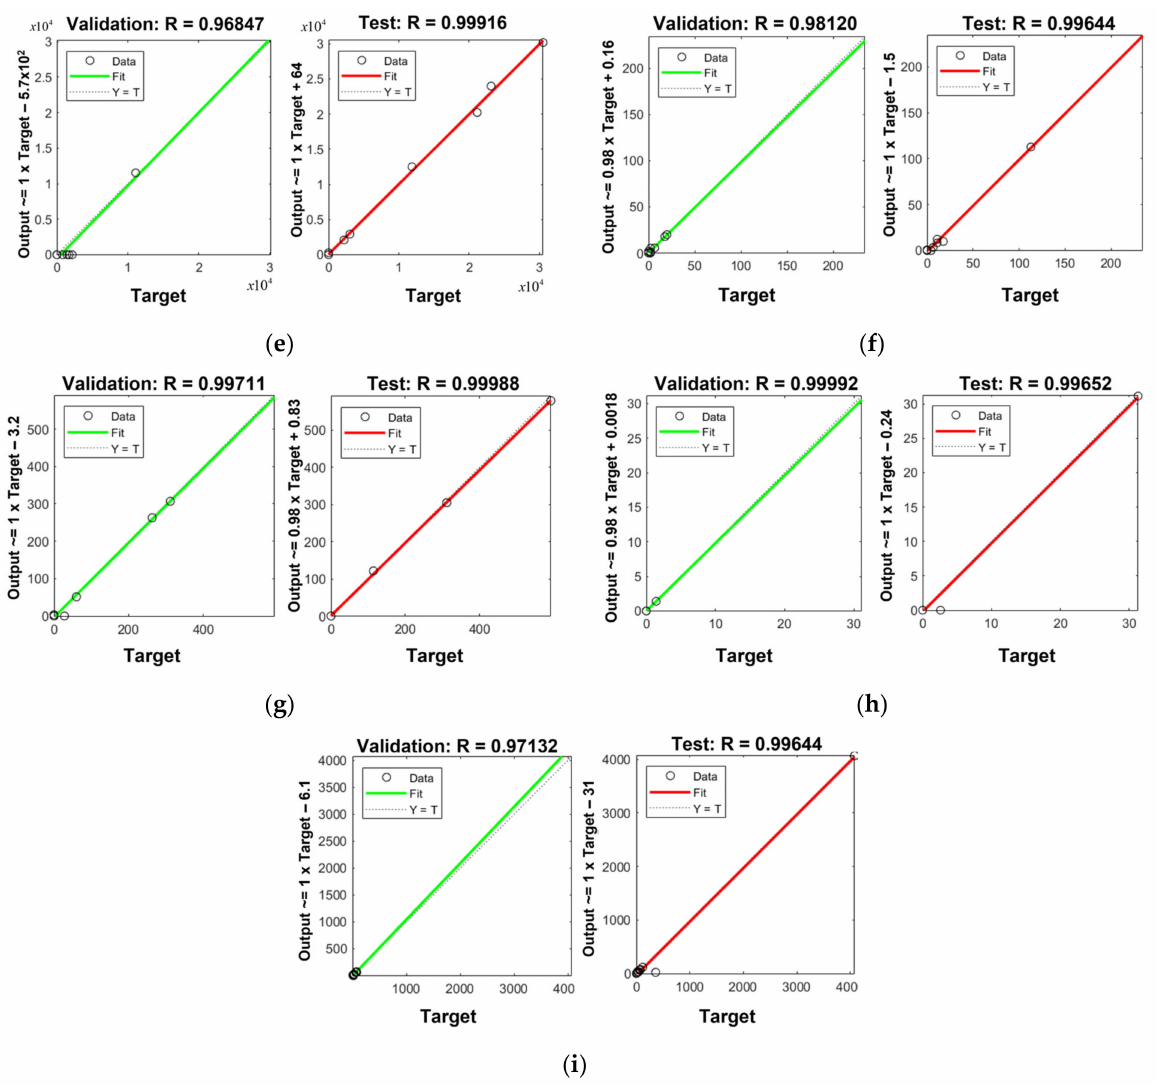
Figure A4. Regression plots for soils: ( a ) Arsenic, ( b ) Barium, ( c ) Chromium, ( d ) Copper, ( e ) Iron, ( f ) Lead, ( g ) Manganese, ( h ) Nickel, ( i )